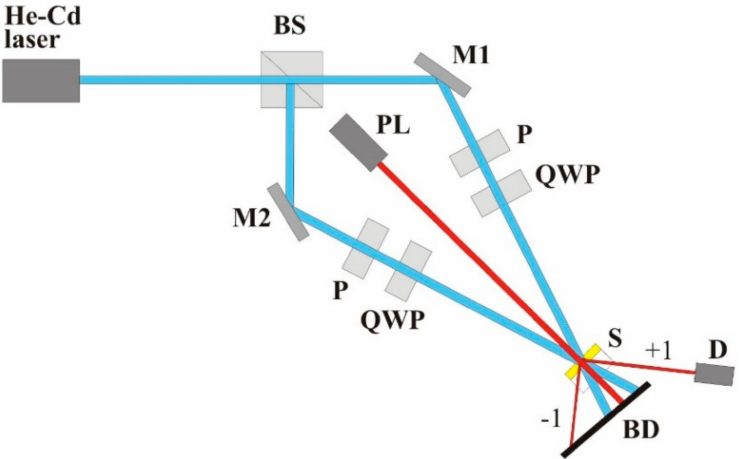
Figure 11. Experimental set-up for holographic grating inscription. S-sample, BS, beam splitter, M1, M2-mirrors, P-polarizer, QWP-quarter-wave plate, PL-probe laser, D- silicon detector, BD-beam